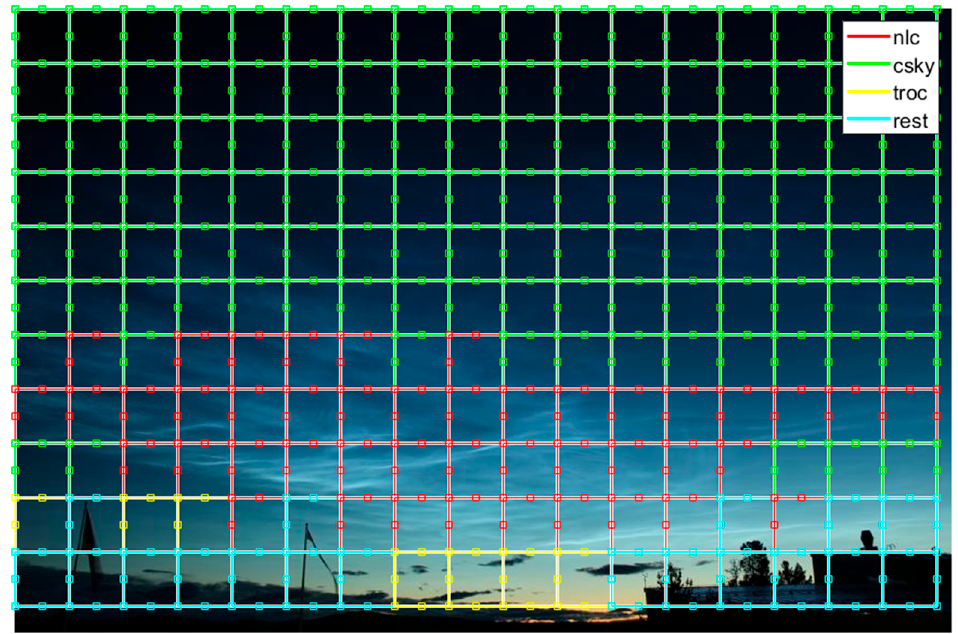
Figure 12. The majority of the noctilucent cloud activity is correctly predicted by the CNN algorithm.